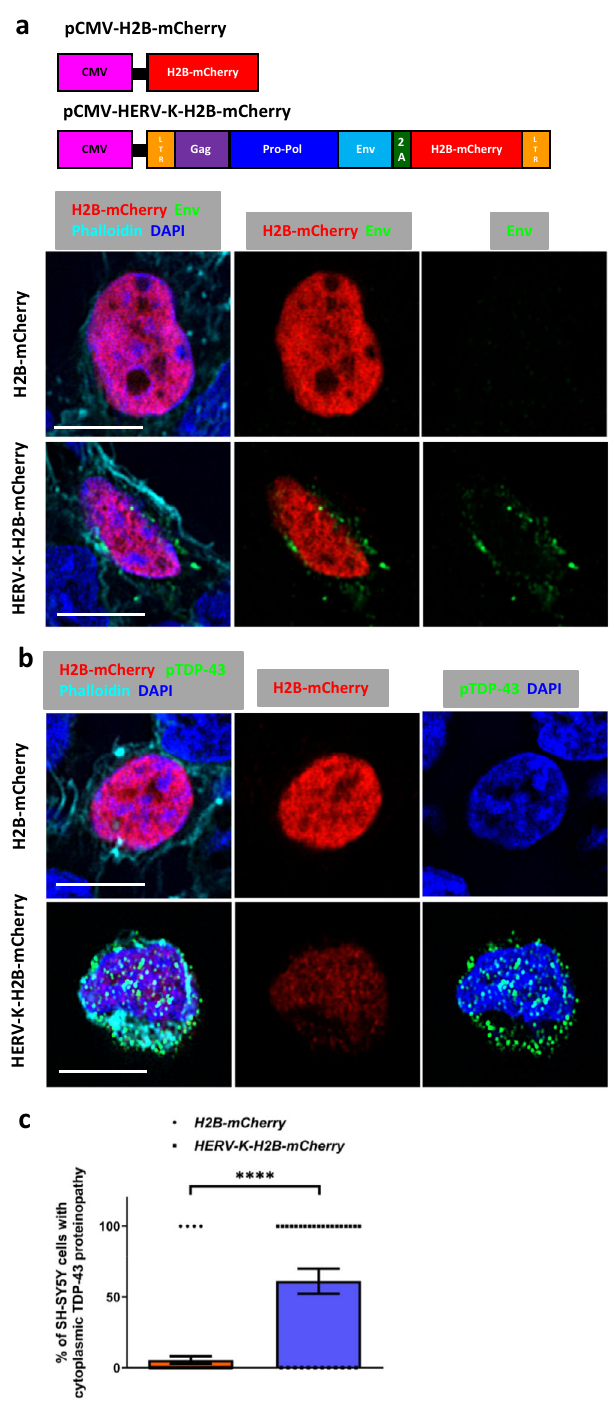
Fig. 1 | Human HERV-K triggers TDP-43 proteinopathy in human neuro- blastoma cells. a A HERV-K-H2B-mCherry construct provides a fl uorescent reporter of HERV-K expression. H2B-mCherry was used as a control. Immuno- fl uorescentimagesofSH-SY5YcellstransfectedwithH2B-mCherryorHERV-K-H2B- mCherryandstainedforHERV-KEnv(green),H2B-mCherry(red),Phalloidin(cyan) and DAPI (blue). Scale bar=5 µ m. mCherry is detected in the nucleus. Env appears as punctate signal at or near the cell membrane. b Immuno fl uorescent images of SH-SY5Y transfected with H2B-mCherry or HERV-K-H2B-mCherry and stained for pTDP-43 (green), H2B-mCherry (red), Phalloidin (cyan) and DAPI (blue). Scale bar=5 µ m. c Quanti fi cation of cytoplasmic pTDP-43 signal in SH-SY5Y cells 2days aftertransfectionwithH2B-mCherryorHERV-K-H2B-mCherry(5.48±2.68%, n =73; 61.29±8.89%, n =31). Data are shown as mean±SEM. A two-tailed unpaired t-test wasperformed.**** p <0.0001. P -valuesforsigni fi cantcomparisonsareprovidedin the Source Data fi